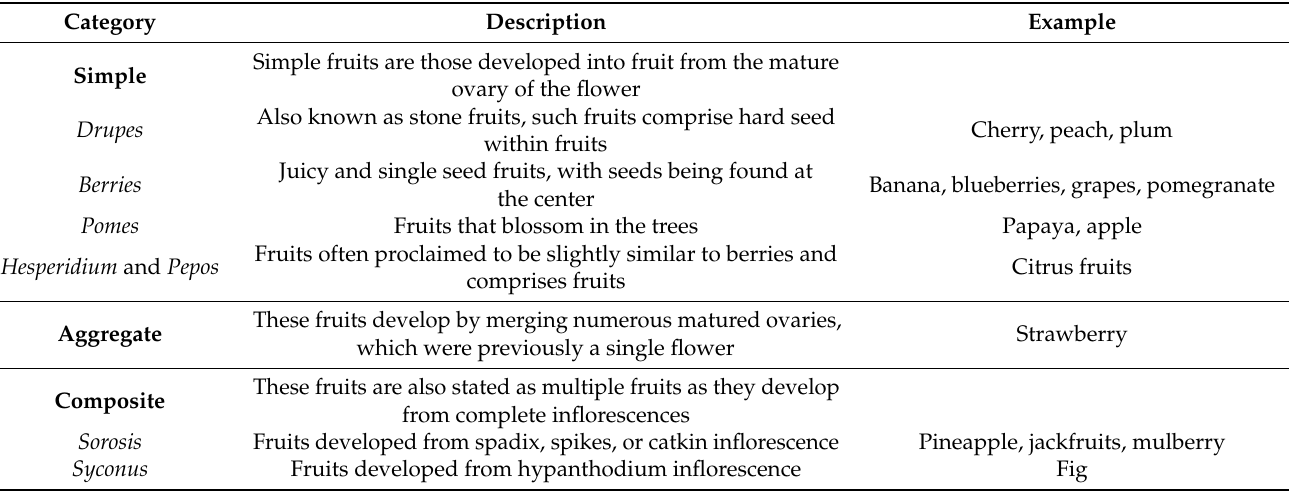
Table 2. Categorization of fruits.